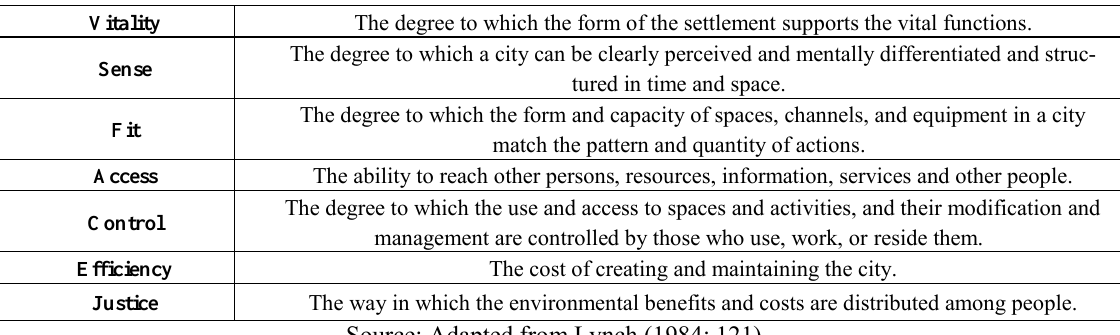
Table 1: Lynch’s spatial planning principles for the best practice city